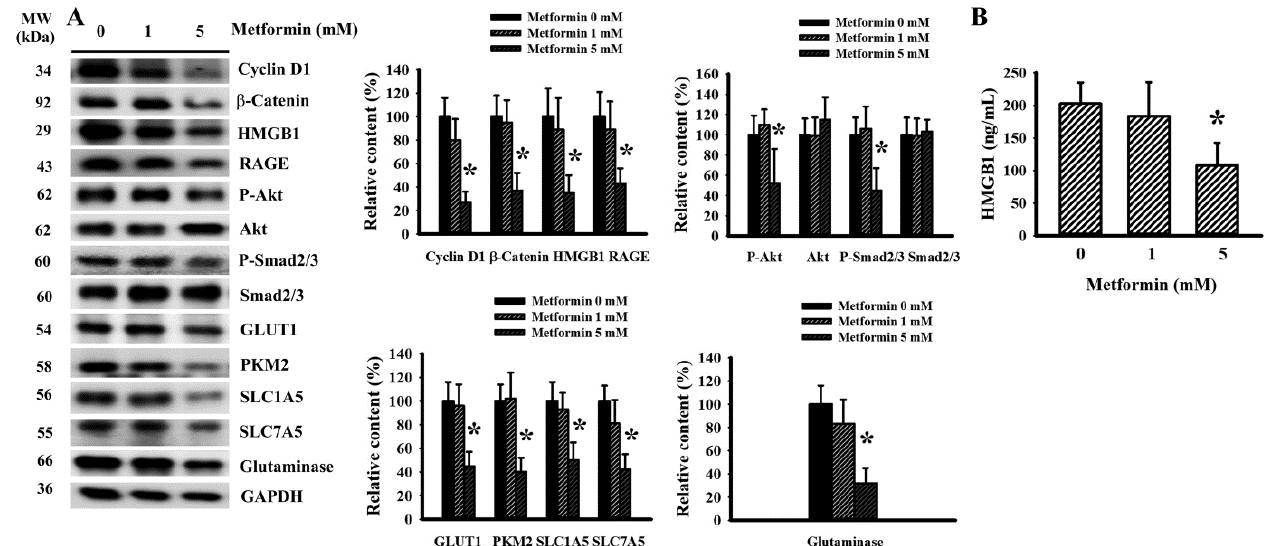
Figure 6. Metformin decreased signaling molecule expression in LLC cells. Metformin (0 – 5 mM) was added to the cultured media of LLC cells for 24 h. The levels of specific proteins in the cell lysates were measured using Western blot with indicated antibodies. Intensity of the specific protein was first normalized with that of GAPDH. For the calculation of relative content, the levels of normalized intensity in metformin (0 mM) group were defined as 100%. Representative blots and quantitative data are shown ( A ). The levels of HMGB1 in the cultured supernatants were measured using ELISA ( B ). * p < 0.05 vs. metformin (0 mM), n = 4.